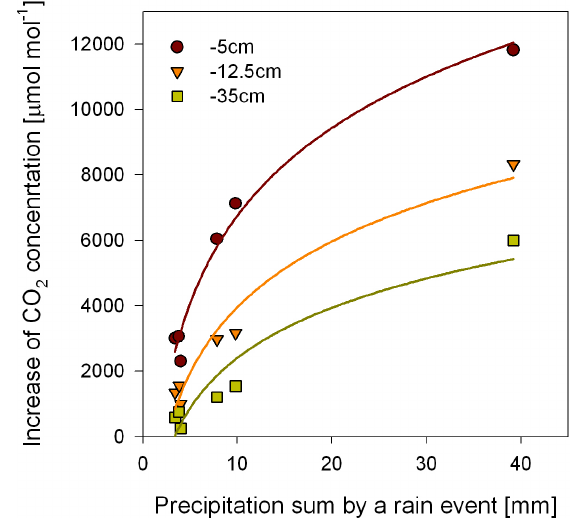
Fig. 7. Increase of CO 2 concentration due to different precipita- tion sums after the summer drought period in August and start of September. Differences between CO 2 concentration maxima (as measured after the rain events) and initial values of CO 2 concen- trations in the half hour prior to the rain at the three measurement depths are presented.